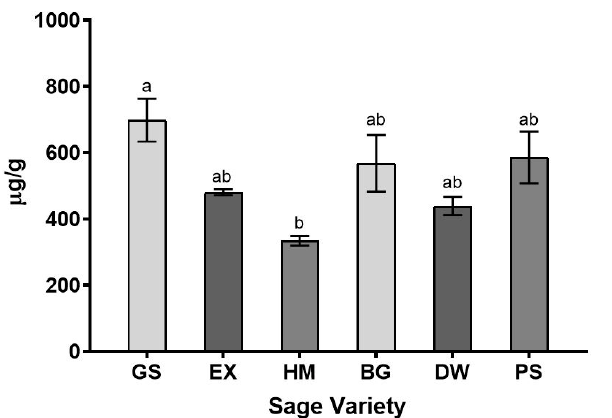
Figure 7. Concentration of B6AG in dried leaves of six culinary sage varieties. Sage varieties are denoted as Garden (GS), Extrakta (EX), Holt’s Mammoth (HM), Berggarten (BG), Dwarf (DW), and Purple (PS). Data are reported as means ± SEM. Samples denoted with the same letter are not statistically distinct.